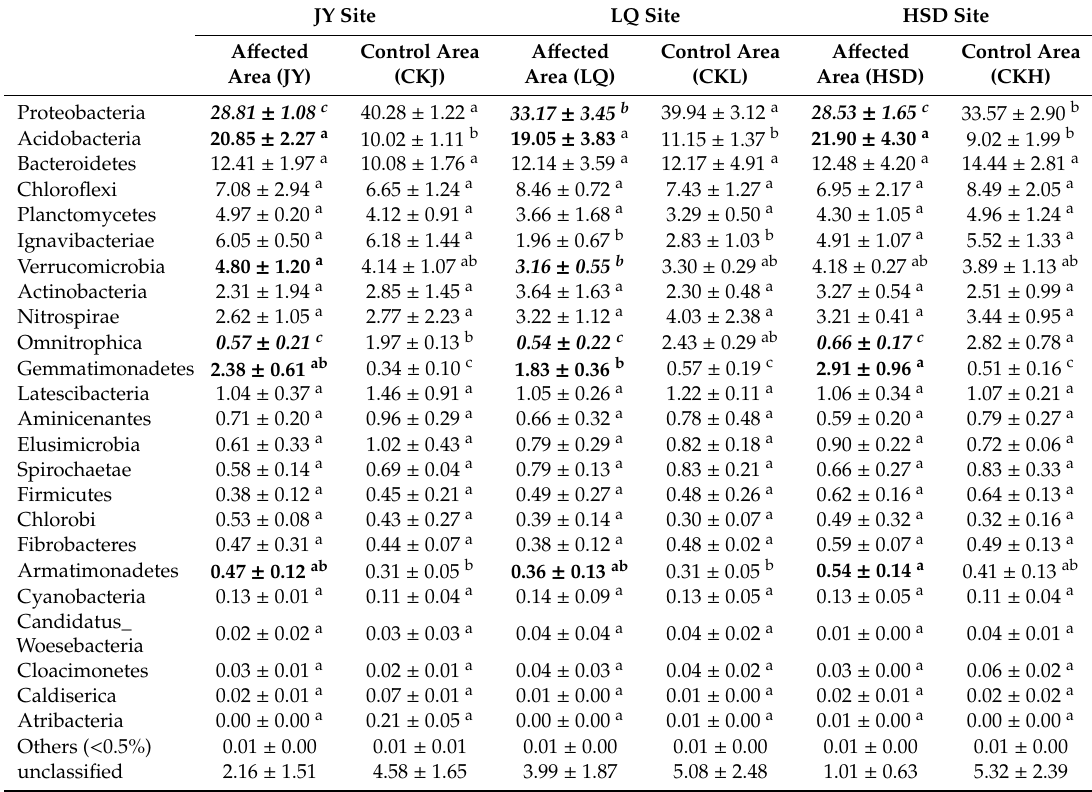
Figure 4. Relative abundance of the bacterial community composition at the phylum level. JY, LQ and HSD represent sampling sites in the highway-affected area, and CKJ, CKL and CKH represent the control sampling sites away from highway in the three turfy swamps. Table 3. Relative abundance of phylum (%) for sequence reads in the three sites (mean ± standard